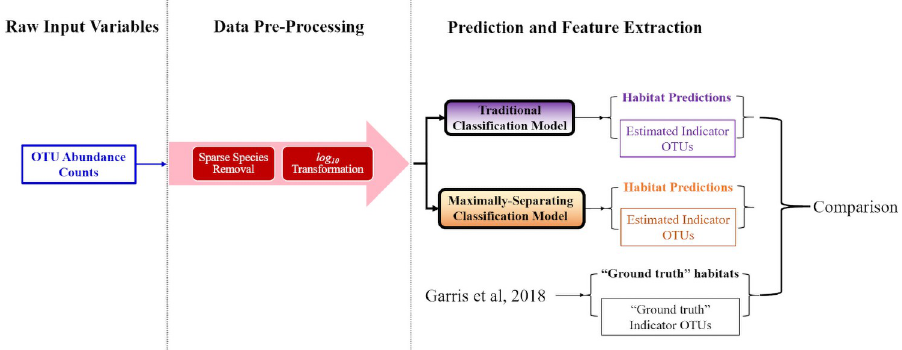
Fig 11. The overall data analysis workflow applied to the Mount Polley case